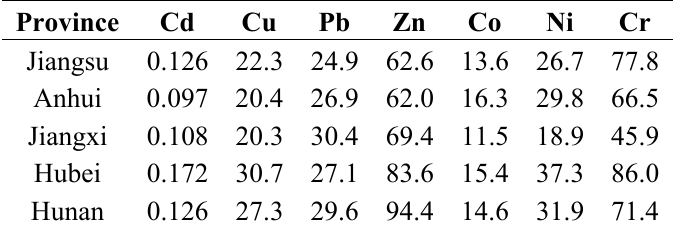
Table 2. Background values of heavy metals (mg·kg − 1 ) in each province where these lakes are